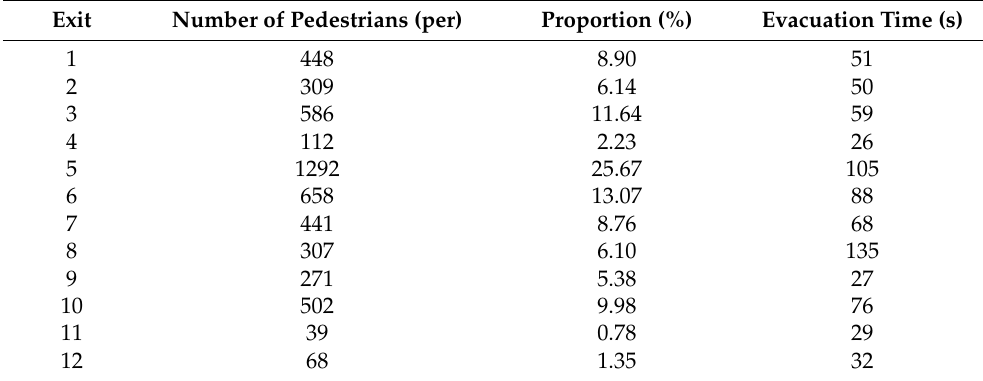
Table 5. Number of pedestrians evacuated and evacuation time at each exit of sample 23.